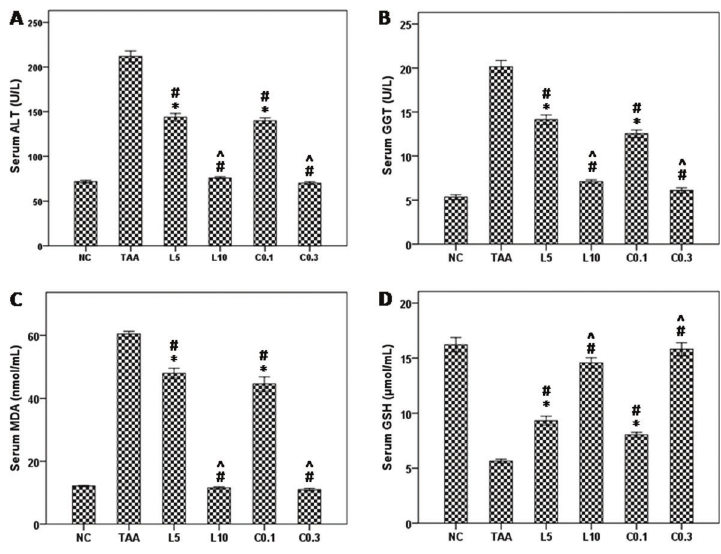
Figure 1. Effects of losartan and candesartan on the serum levels of: A , alanine aminotransferase (ALT), B , g -glutamyl transferase (GGT), C , malon- dialdehyde (MDA), and D , glutathione (GSH) in thioacetamide (TAA)-induced chronic liver failure rats. Losartan (L5 and L10; 5 and 10 mg (cid:1) kg – 1 (cid:1) day – 1 ) and candesartan (C0.1 and C0.3; 0.1 and